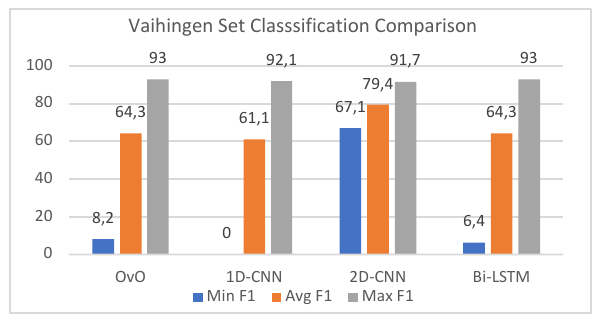
Figure 9. Minimum, average and maximum F1 scores comparisons by algorithm for Vaihingen dataset. Abbrev.